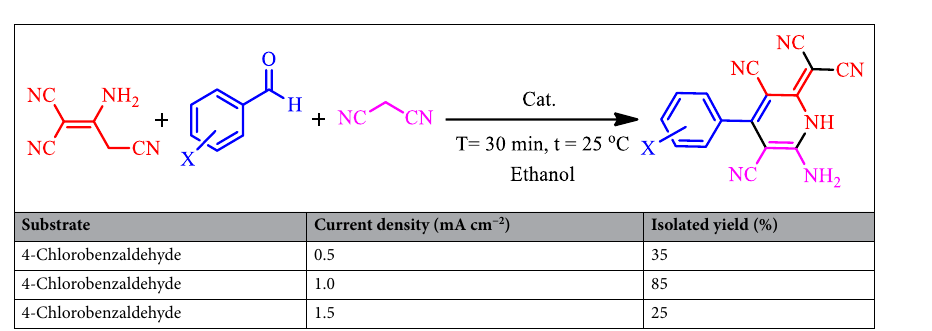
Table 3. Optimization of conditions for the synthesis of dicyanomethylene pyridine.